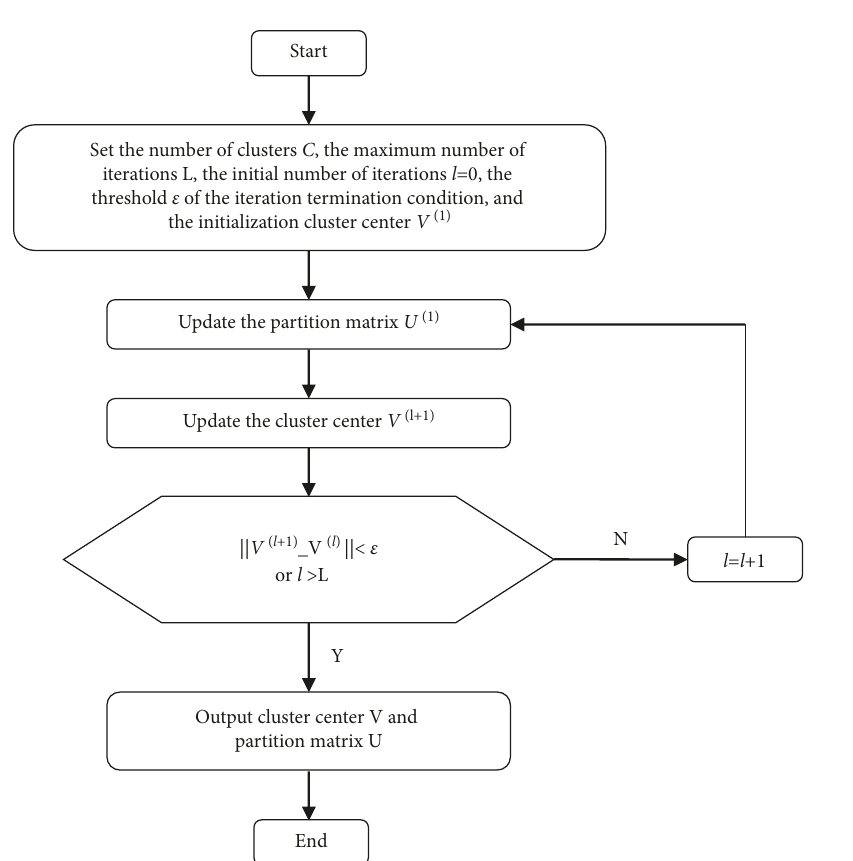
Figure 2: Cost risk composition of power grid construction